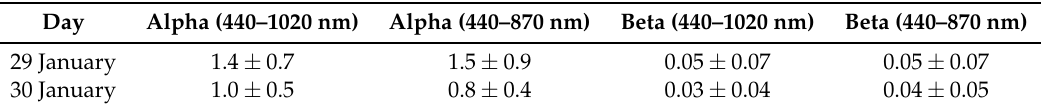
Table 2. Average Ångström coefficients α p and β p for the two days of MIISP acquisitions. Average values obtained using different wavelength pairs (440/1020 and 440/870 nm) are reported.